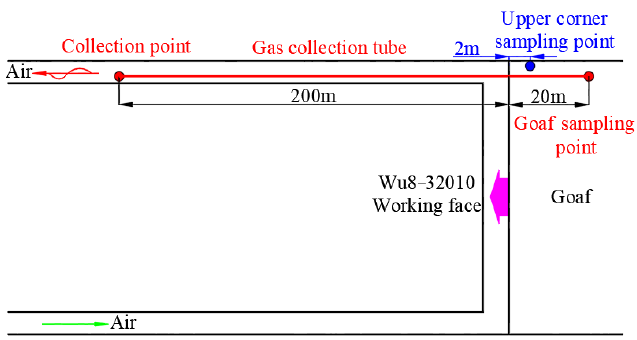
Figure 3. Mixed gas sample collection location